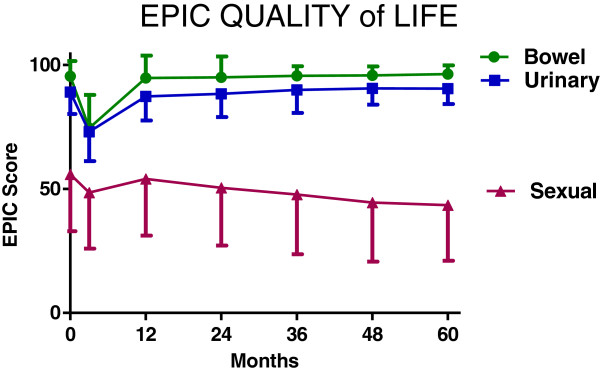
Mean EPIC quality of life scores. Under the figure are percentages of patients reaching each time point that completed the EPIC ((number completing EPIC / number at risk) X 100).